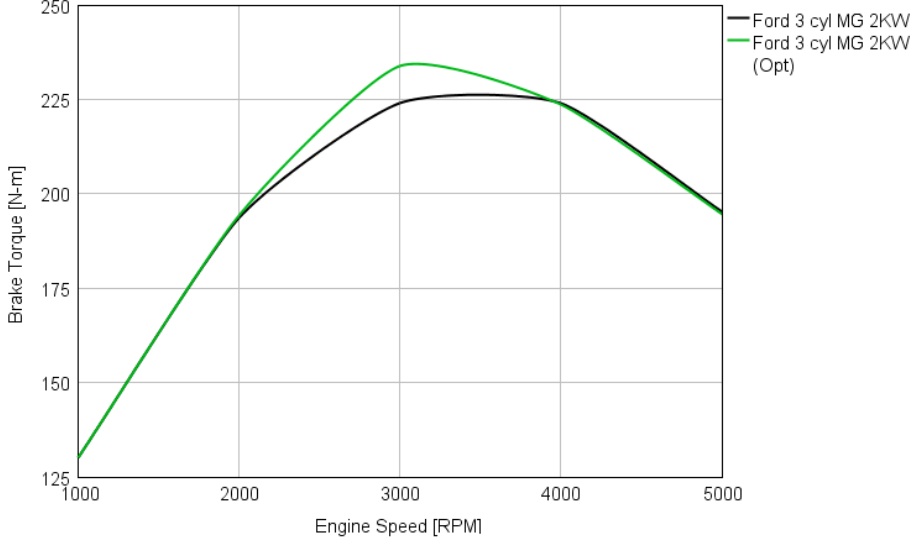
Figure 21. Brake Torque graphs for the initial (black) and optimized (green) EAT 2 kW models.